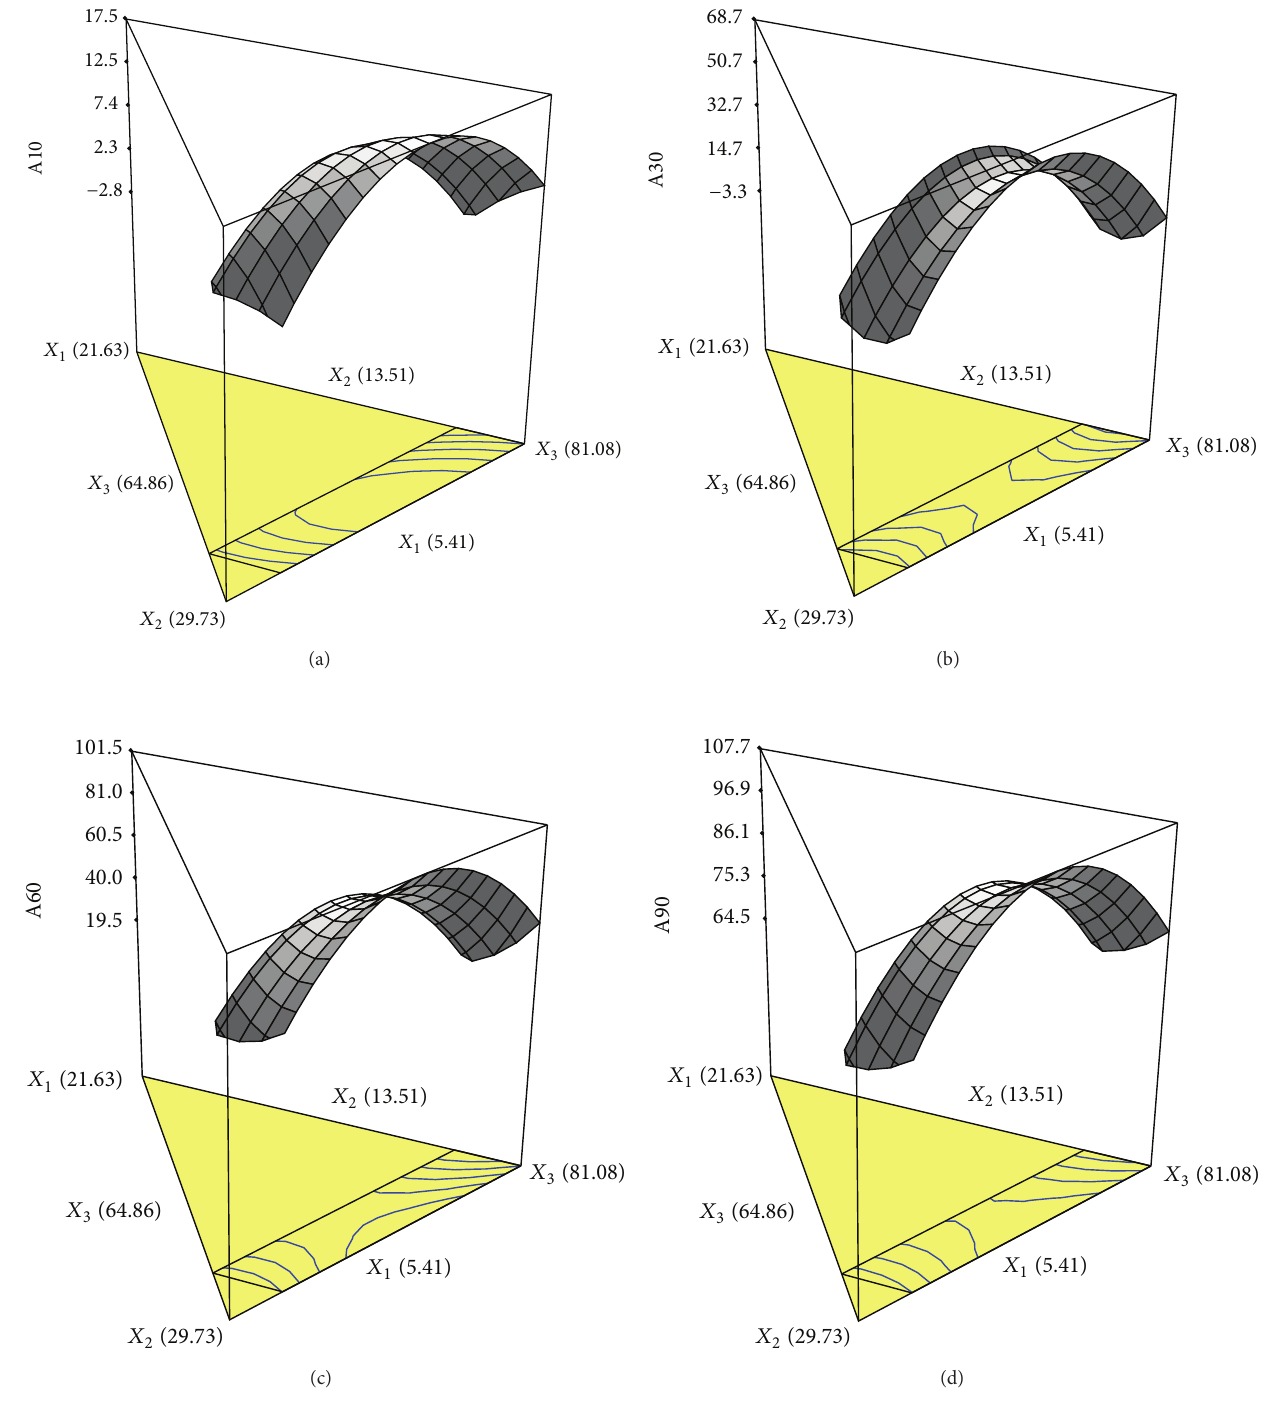
Figure 2: The three-dimensional contour diagrams illustrating the effect of beeswax ( 𝑋 1 ), hydrogenated coconut oil ( 𝑋 2 ), and soybean oil ( 𝑋 3 ) on the isotretinoin release percentage at 10min (a), 30min (b), 60min (c), and 90min